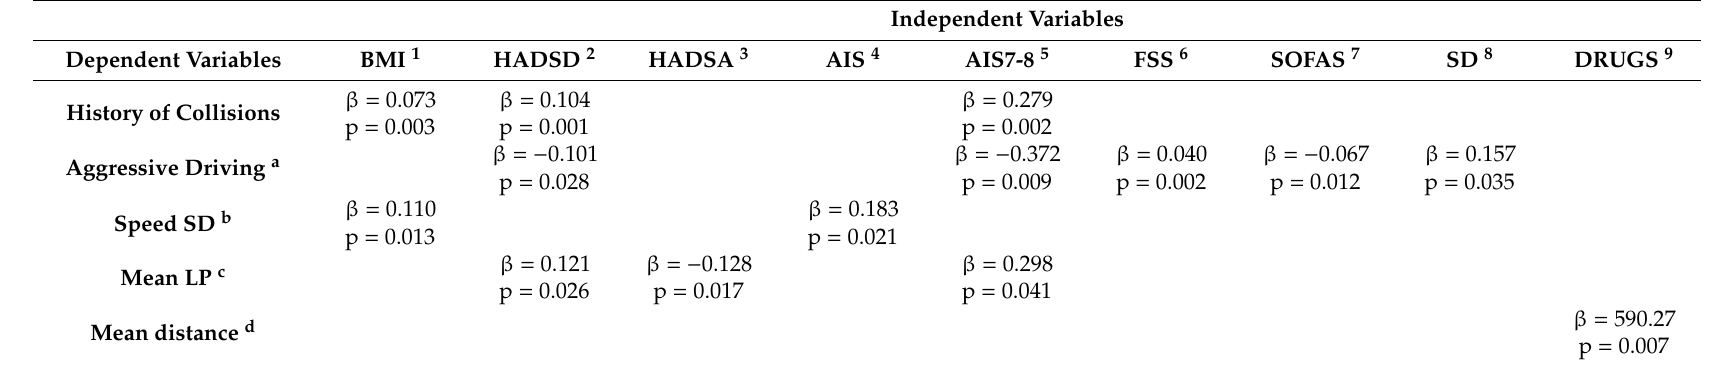
Table 3. Main findings from the final models of multiple backward